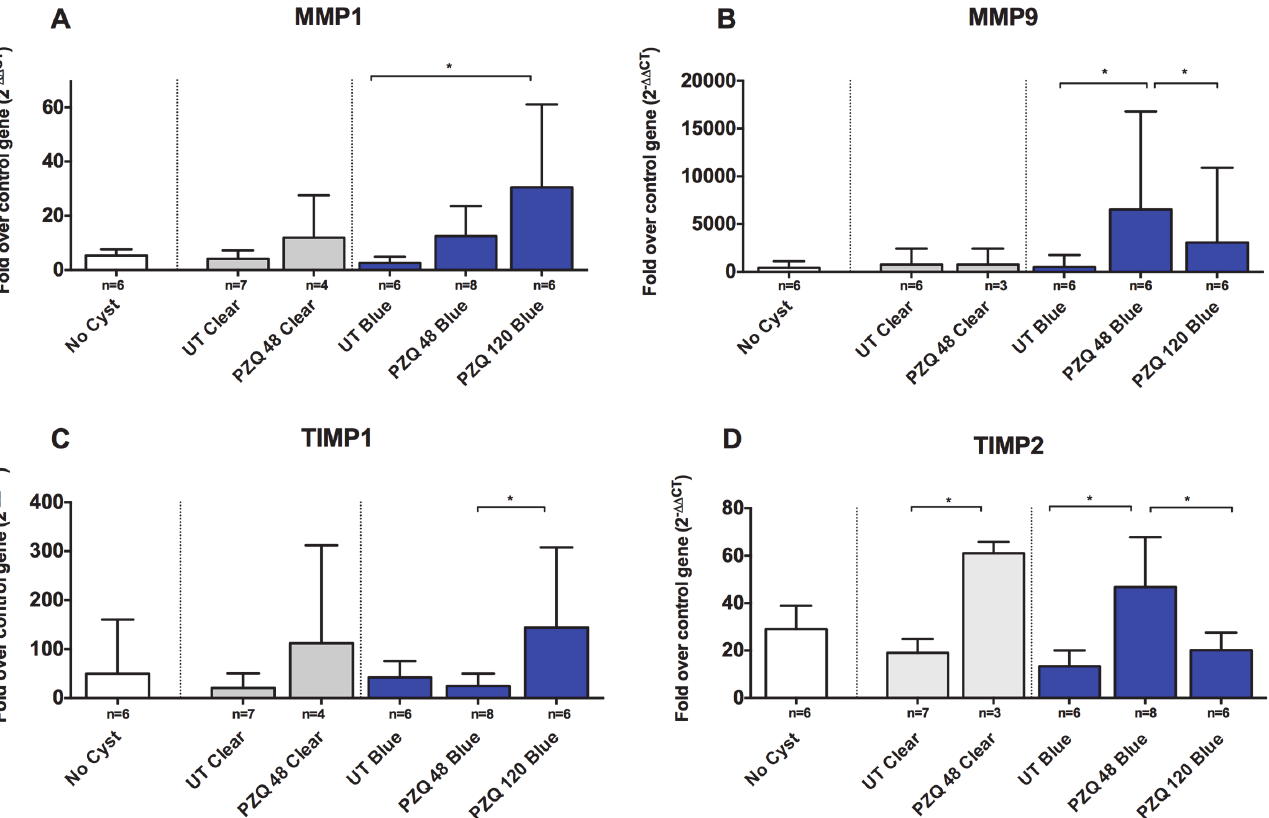
Fig 6. Increased expression of fibrosis/granuloma promoting genes in EB and clear capsules. Methods and tissues examined are identical to those analyzed in Figs. 3 – 5. Shown are four genes representative of fibrosis and granuloma promoting molecules: MMP1 (A; number [n] of samples for the indicated types of capsules are shown below each bar; n = 7, 6, 3, 6, 6, respectively), MMP9 (B), TIMP1 (C) and TIMP2 (D). Statistically significant differences in levels of gene expression are indicated by asterisks (p < 0.05, Mann-Whitney U test). Asterisks represent level of significance: * : p < 0.05; ** : p < 0.01; *** : p <